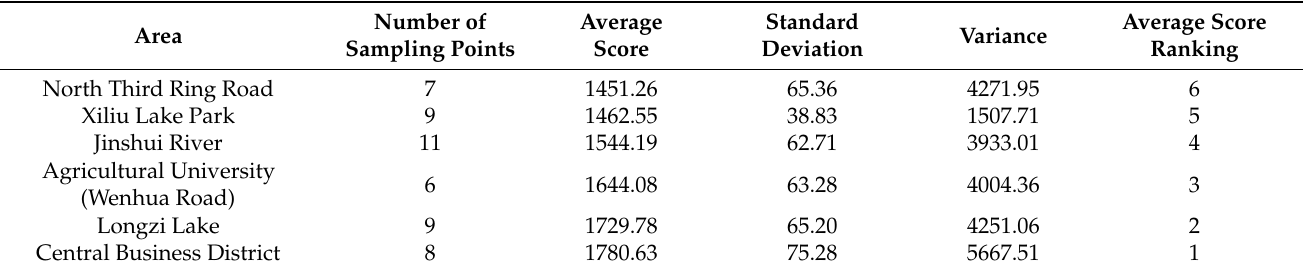
Table 2. The visual effect scores of different sampling areas.